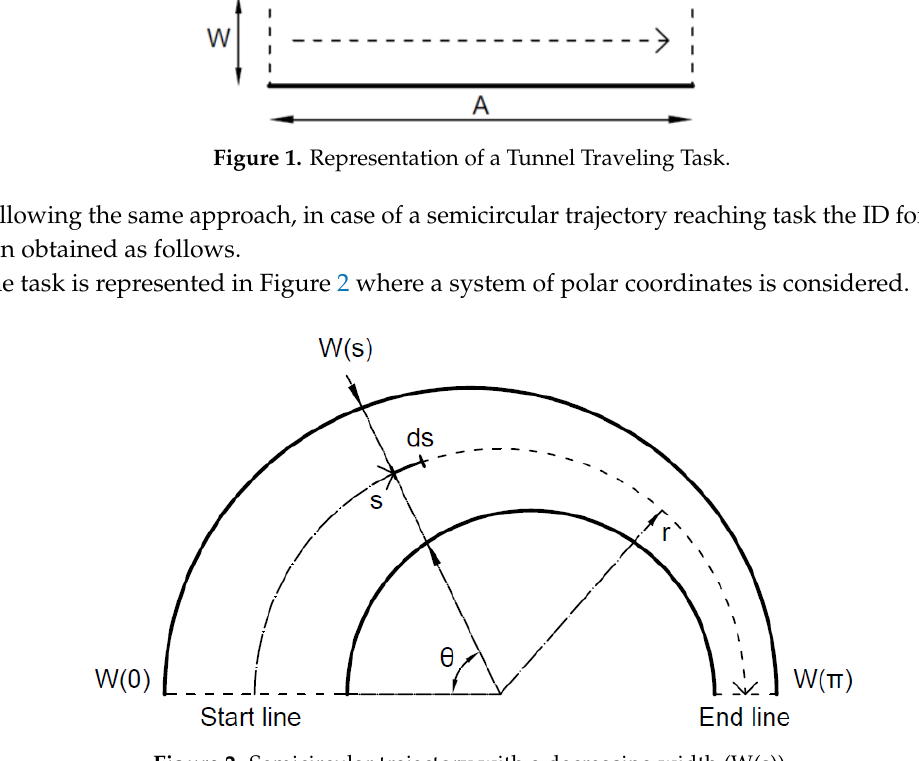
Figure 2. Semicircular trajectory with a decreasing width (W(s)).